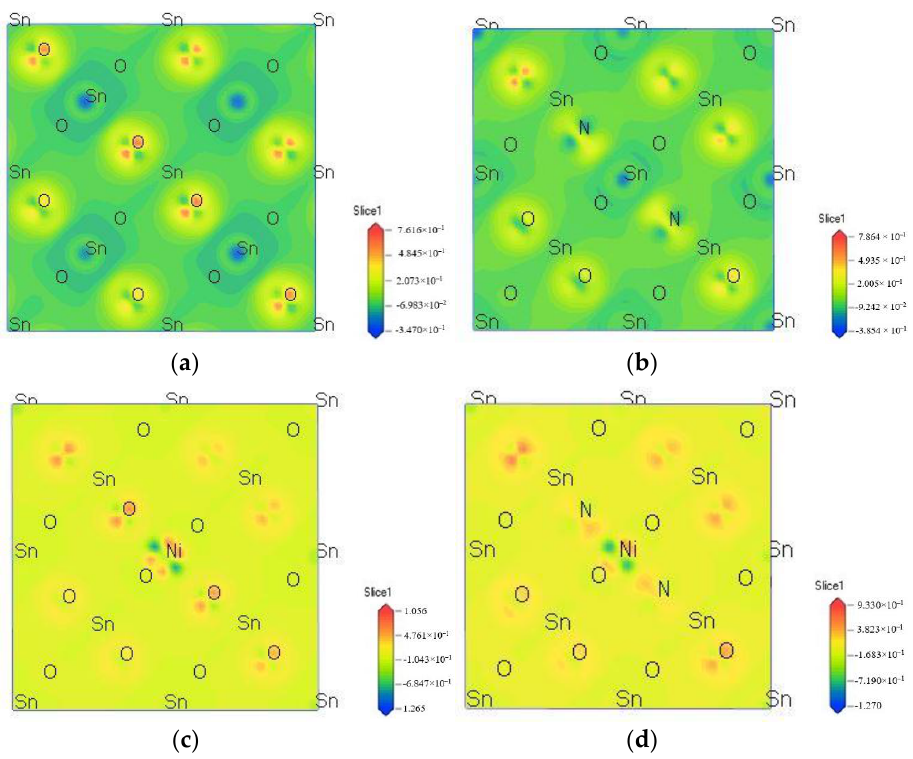
Figure 4. Charge density map: ( a ). SnO 2 ; ( b ). SnO 2 – Ni; ( c ). SnO 2 – N; ( d ). SnO 2 – Ni – N. Table 2. Atom population and electronic overlapping populations.